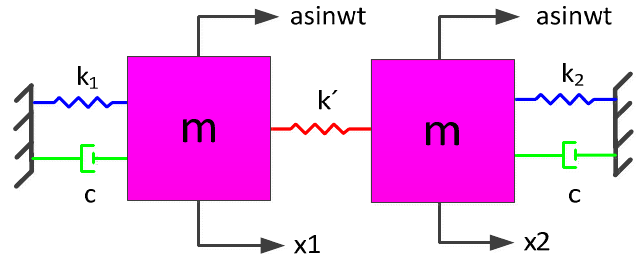
Figure 4. The model of the non-ideal TFG.